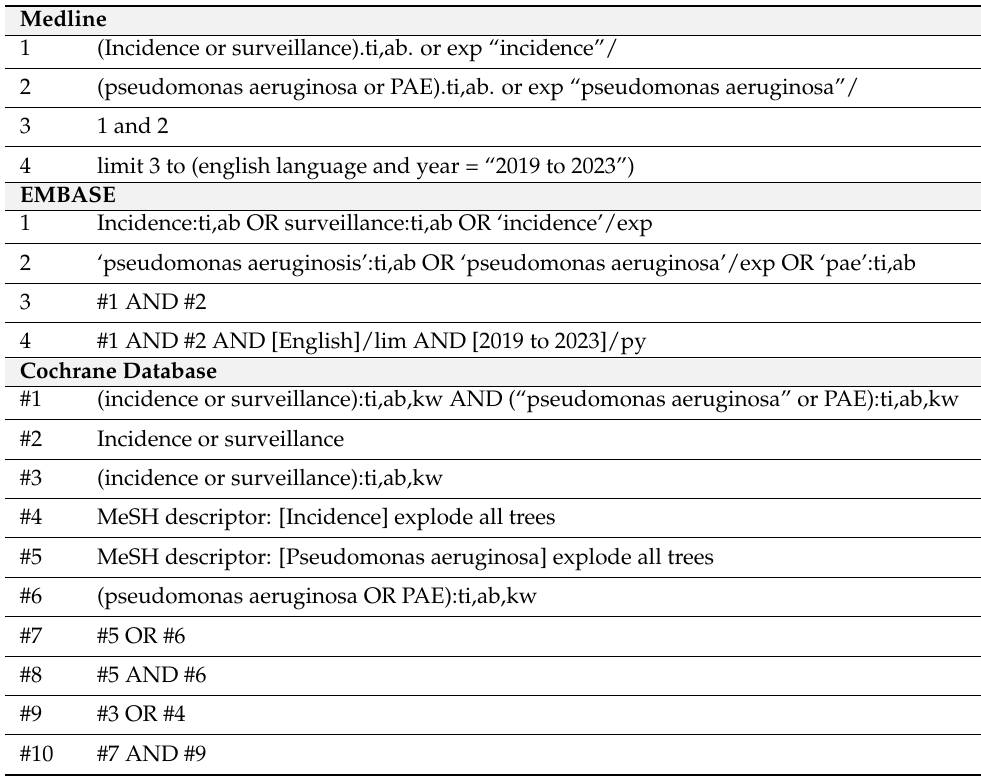
Table 1. Full search strategy for Medline, Embase, and Cochrane